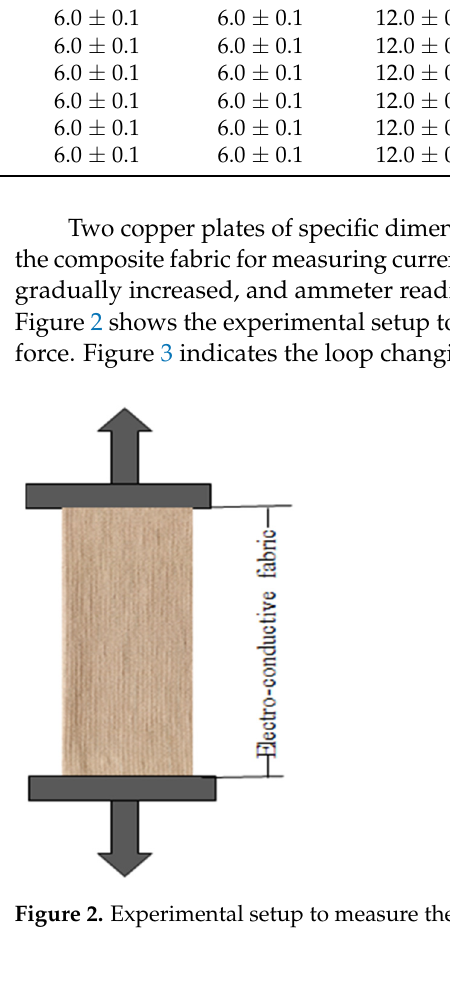
Table 1. Essential parameters of designed composite fabrics.